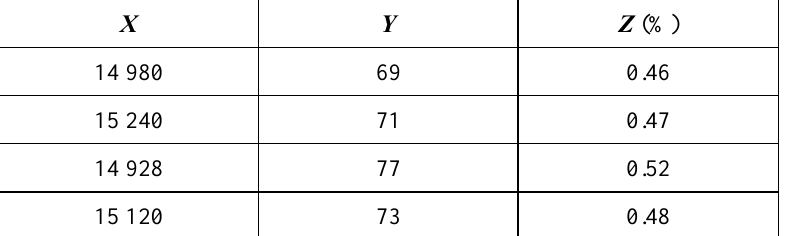
Table 6. Re-inspection results of machine using qualified products by